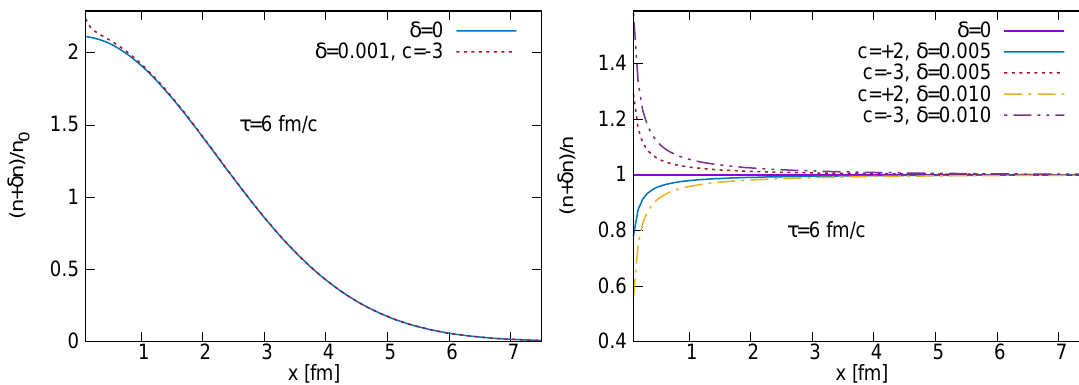
Figure 3. The perturbed density n + δ n is shown in the left plot as a function of x , for τ = 6 fm/ c (the other parameters are given in the text). The right plot indicates the relative change ( n + δ n ) / n for various δ and c